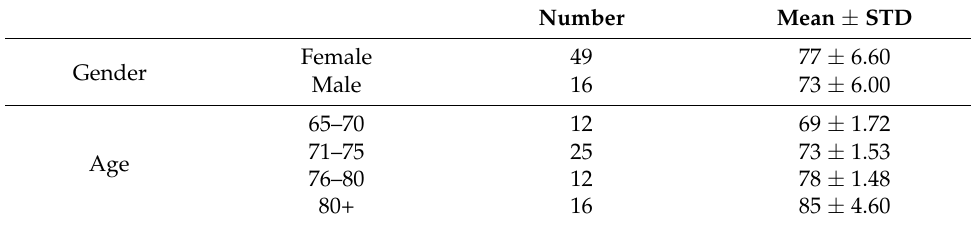
Table 1. Demographic data of the subjects who participated in this